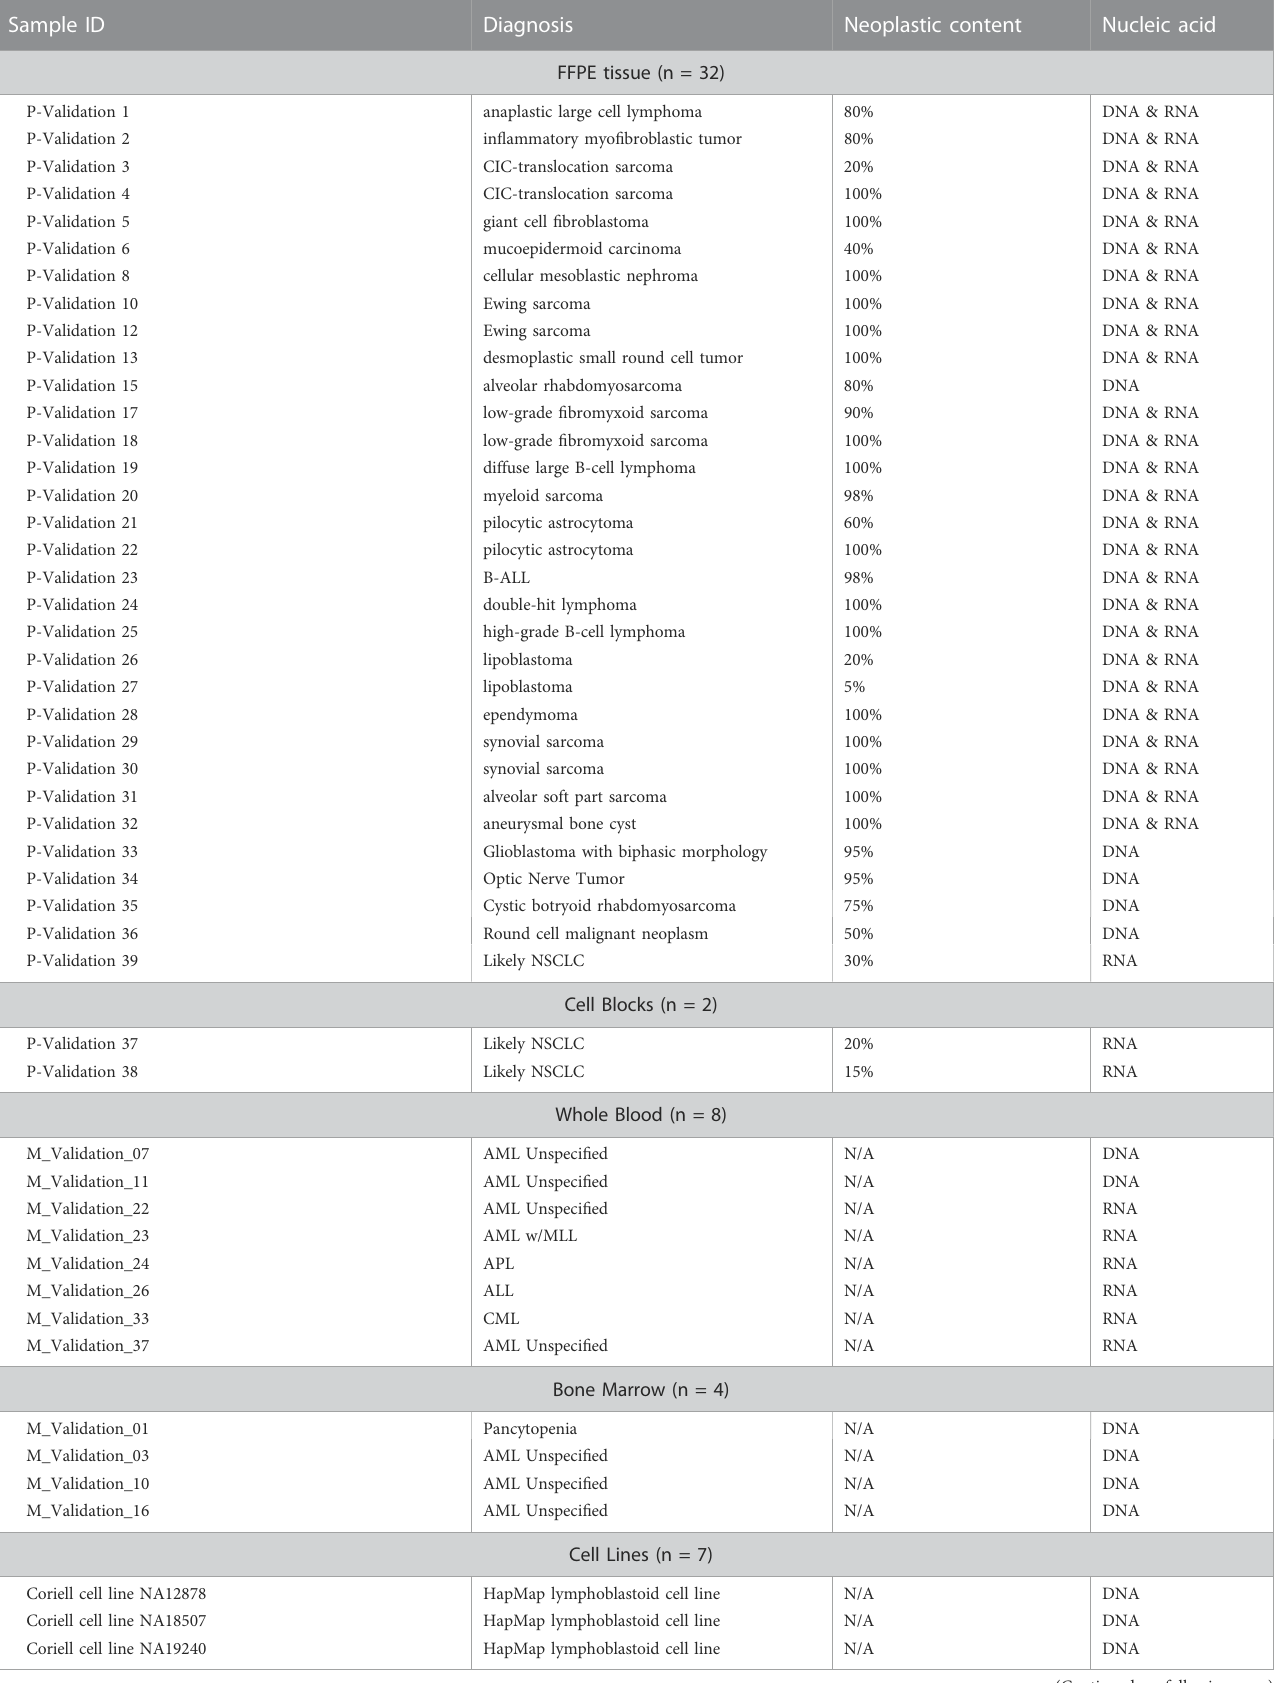
TABLE 3 Study Cohort. Details of specimens used in